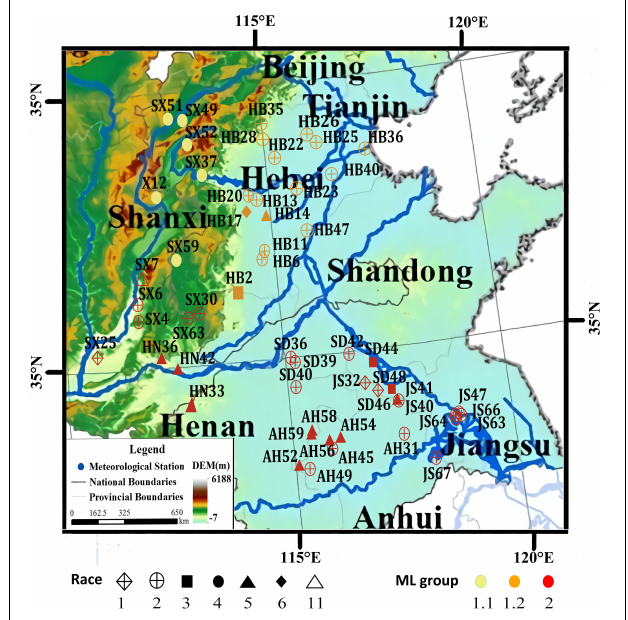
FIGURE 3 | The spatial distribution of 54 populations of the SCN in the Huang-Huai Valleys in China. Adopted from Yuan et al. (2019) with permission. SCN sample location, race, and ML group